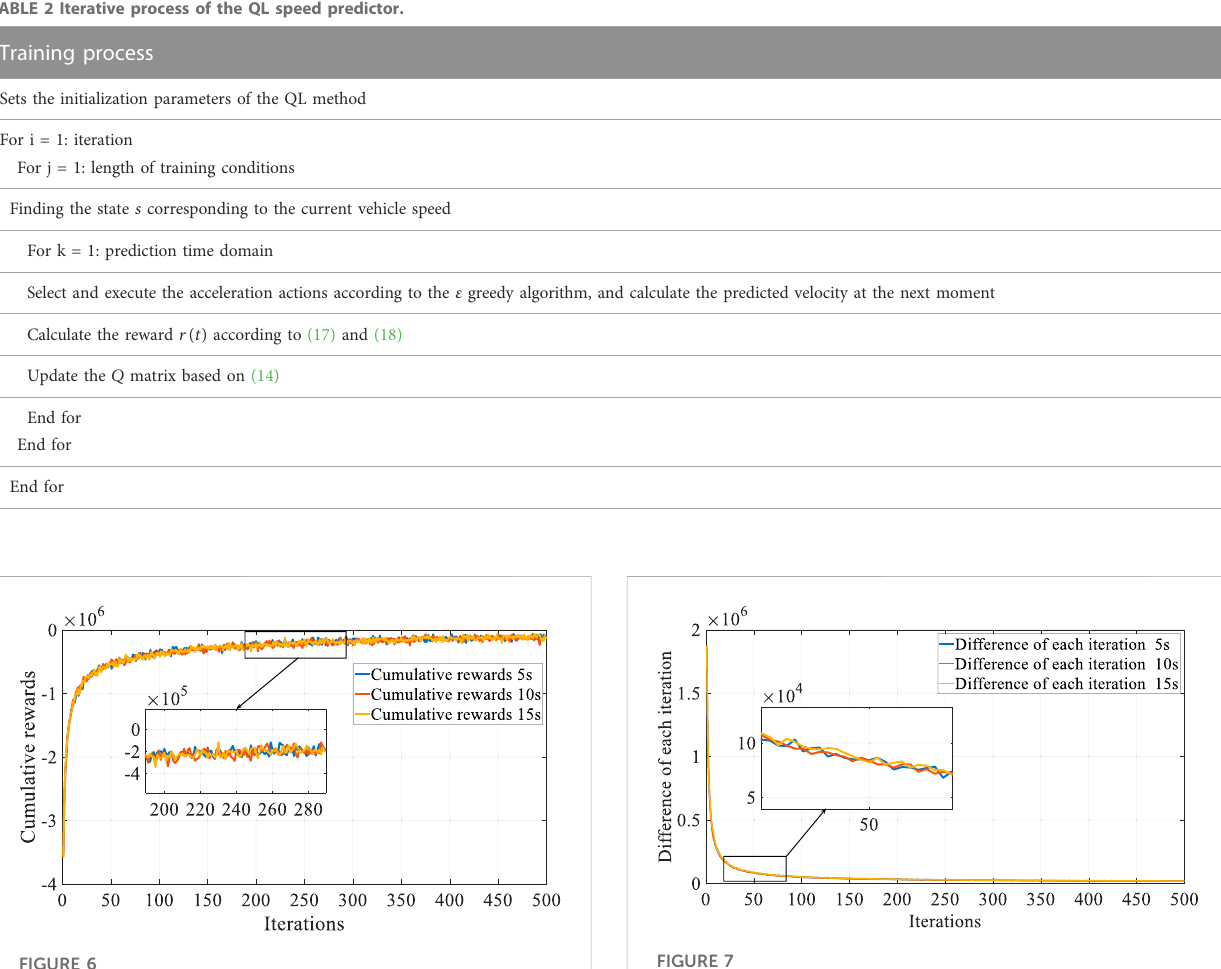
FIGURE 7 Cumulative reward difference for each